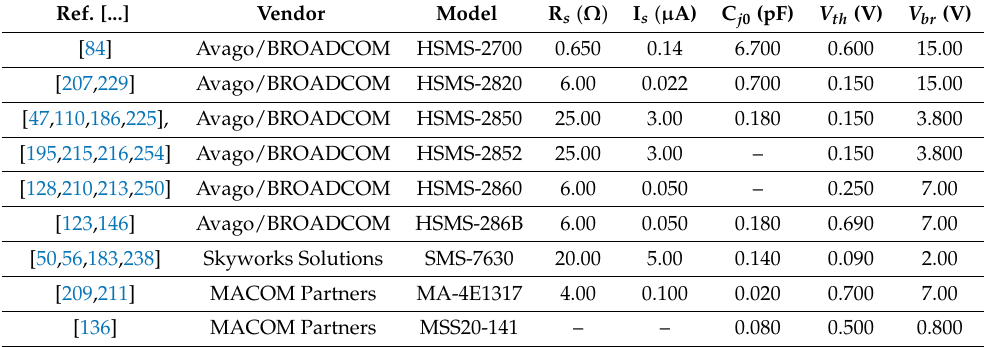
Table 6. Electrical specifications of some basic Schottky RF diode models deployed in the RFEH